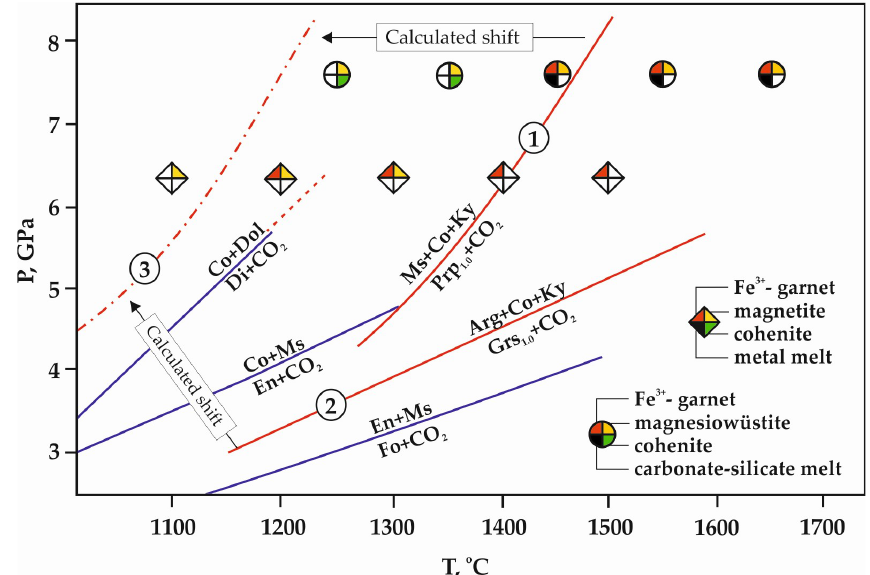
Figure 7. P,T-diagram with experimental results of the carbide–oxide–carbonate interaction “sandwich”-type (circles) and “mixture”-type (rhombs) experiments, with experimentally determined or calculated decarbonation curves [52–54]. Color of symbols denotes variations in Fe-bearing phases. Calculated shift of Reactions (1) and (2), which results in Reaction (3), are shown according to EC1 garnet compositions [54]. Co, coesite; Dol, dolomite; Di, diopside; Ms, magnesite; En, enstatite; Ky, kyanite; Prp, pyrope; Grs, grossular.